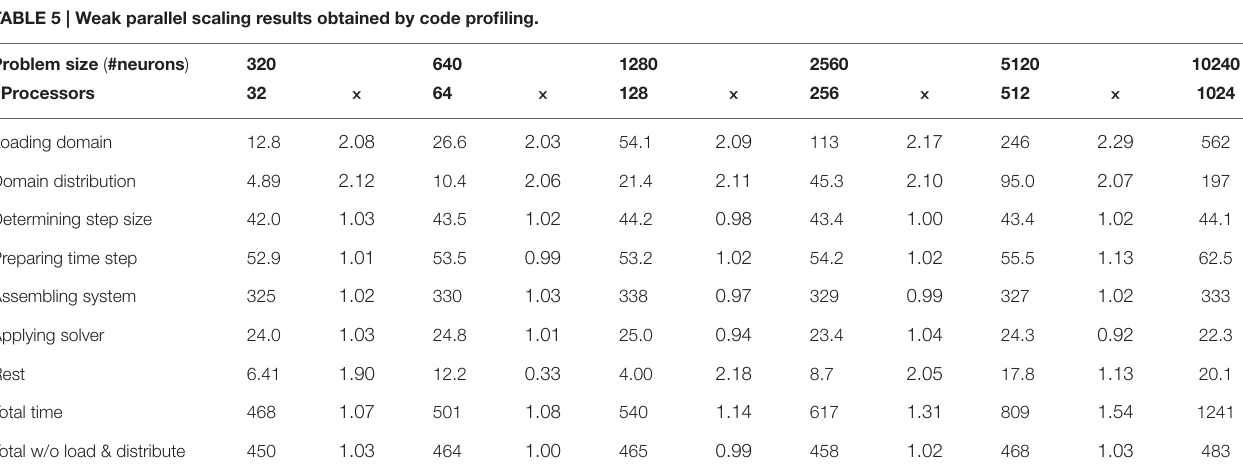
TABLE 5 | Weak parallel scaling results obtained by code